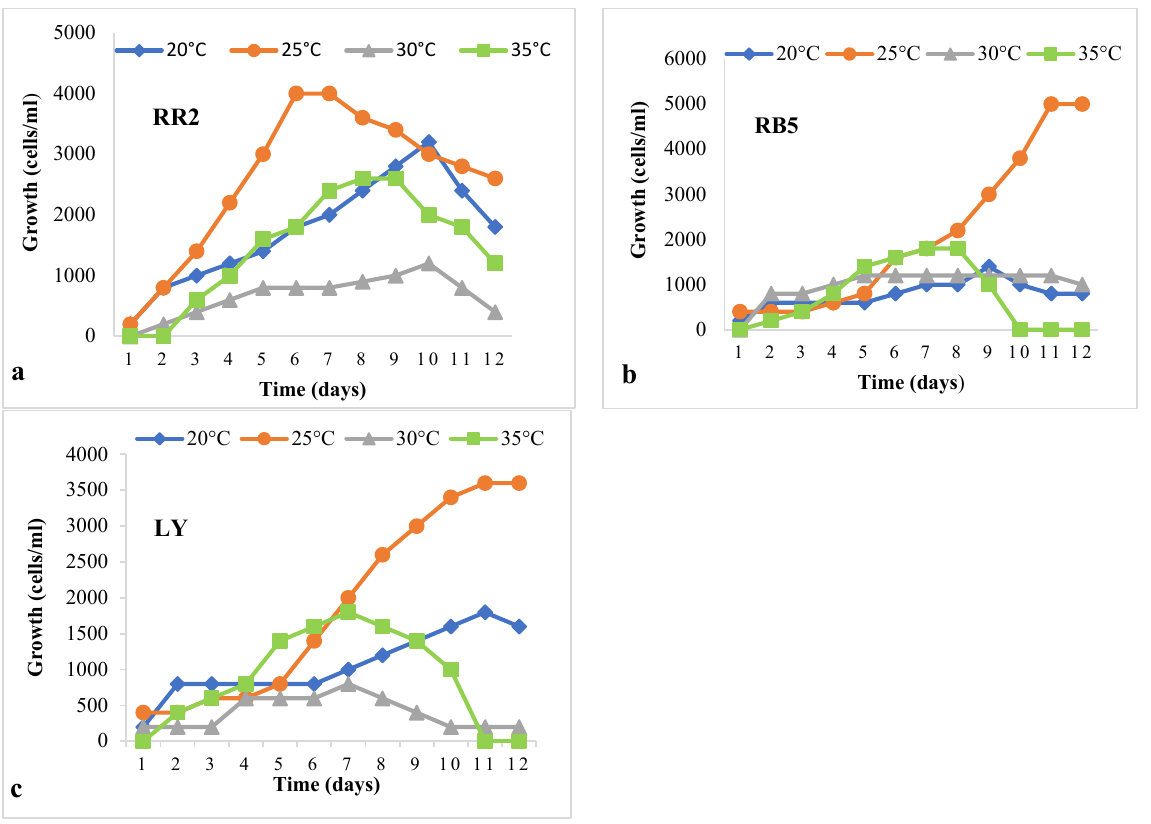
Figure 4. Decolorization/degradation of different dyes by P. caudatum UR03 in 100 mL of culture medium inoculated with 10 ul of azo dyes over a period of 10 days. ( a ) Showed the decolorization profile of different dyes monitored after every 24 h for 10 days. ( b ) Showed the azo dye degradation as indicated by decolorization in the flasks.